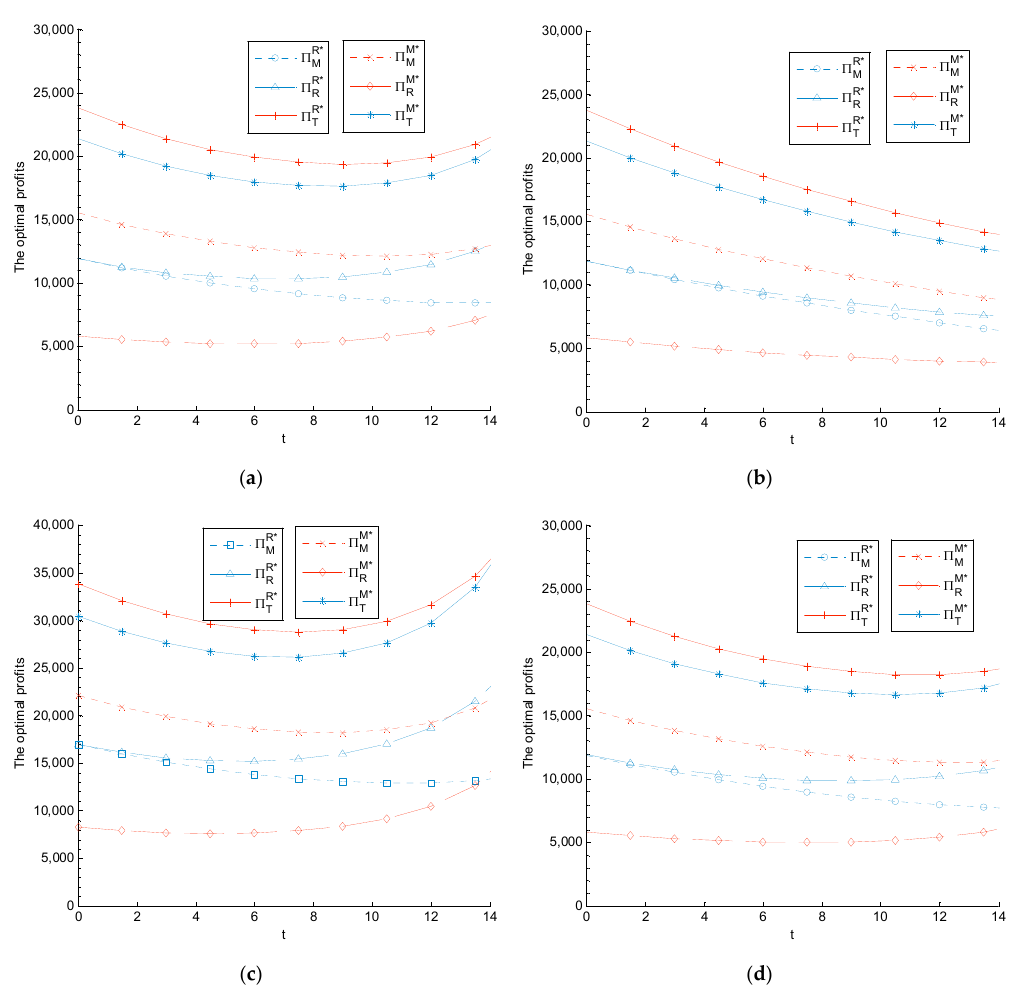
Figure 3. The impact of carbon tax on the supply chain members’ equilibrium profits: ( a ) θ = 5 and m = 10; ( b ) θ = 12 and m = 10; ( c ) θ = 6 and m = 1; and ( d ) θ = 6 and m =